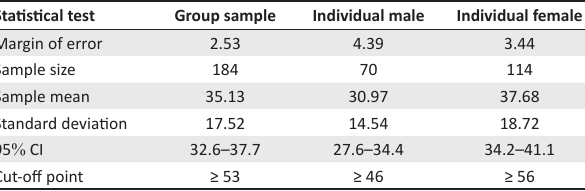
TABLE 5: The 95 % confidence interval of cut-off point determination for the Redeemer’s University Suicidality Scale by sex.